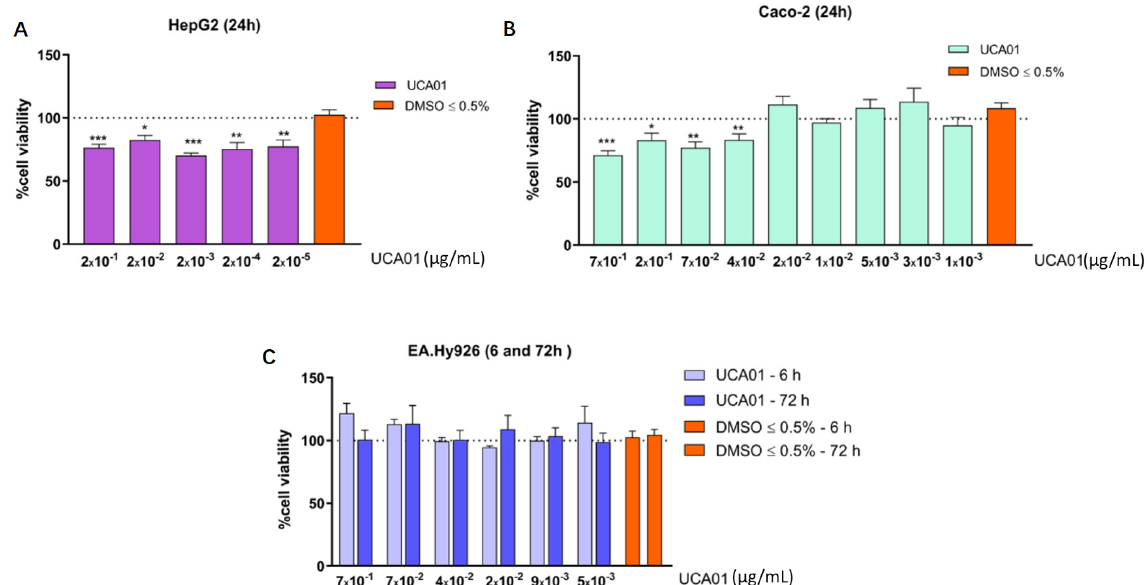
Figure 3. Antiproliferative effect of the recombinant UCA01 of N. gaditana . Antiproliferative effect was evaluated using different prohibitin or dimethylsulfoxide (DMSO) (vehicle) concentrations on human cell lines: ( A ) HepG2 (tumor cell line) after 24 h of contact; ( B ) Caco-2 (tumor cell line) after 24 h of contact; ( C ) EA.hy926 (nontumor/control cell line) after 6 h and 72 h of contact. The dashed line represents 100% cell viability obtained with each cell line without treatment. Data are expressed as means ± standard errors of the mean (SEM). For statistical analysis, Student’s t -test was used to compare each datum with the vehicle control DMSO (* p ≤ 0.05; ** p ≤ 0.01 and *** p ≤ 0.001).